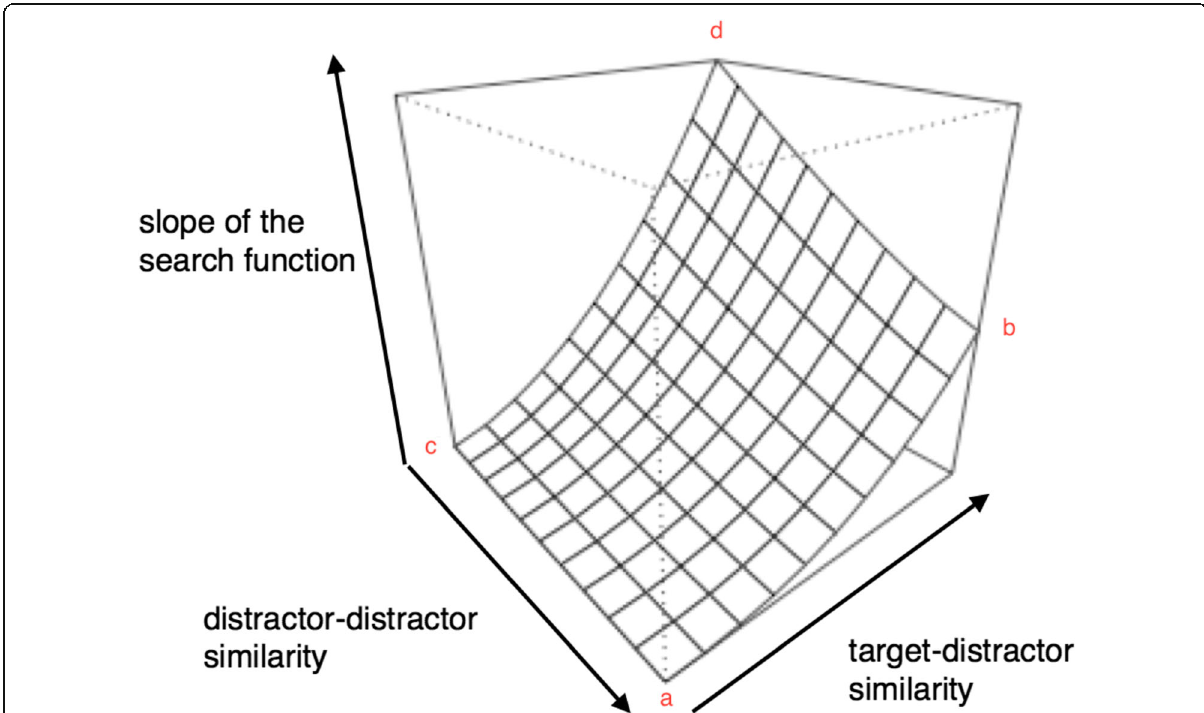
Fig. 1 The search surface. Slope of the search function indicates the slope of reaction time over an increasing set size. It is plotted as a function of target – distractor similarity (TDS) and distractor – distractor similarity (DDS). Due to the grouping of similar items, high search efficiency arises in conditions with low TDS (points a and c). Here, the target visually “ pops out. ” Low search efficiency arises on the opposite corners of the cube. It is especially pronounced when DDS is low (point d). Adapted from Duncan & Humphreys (1989, p.